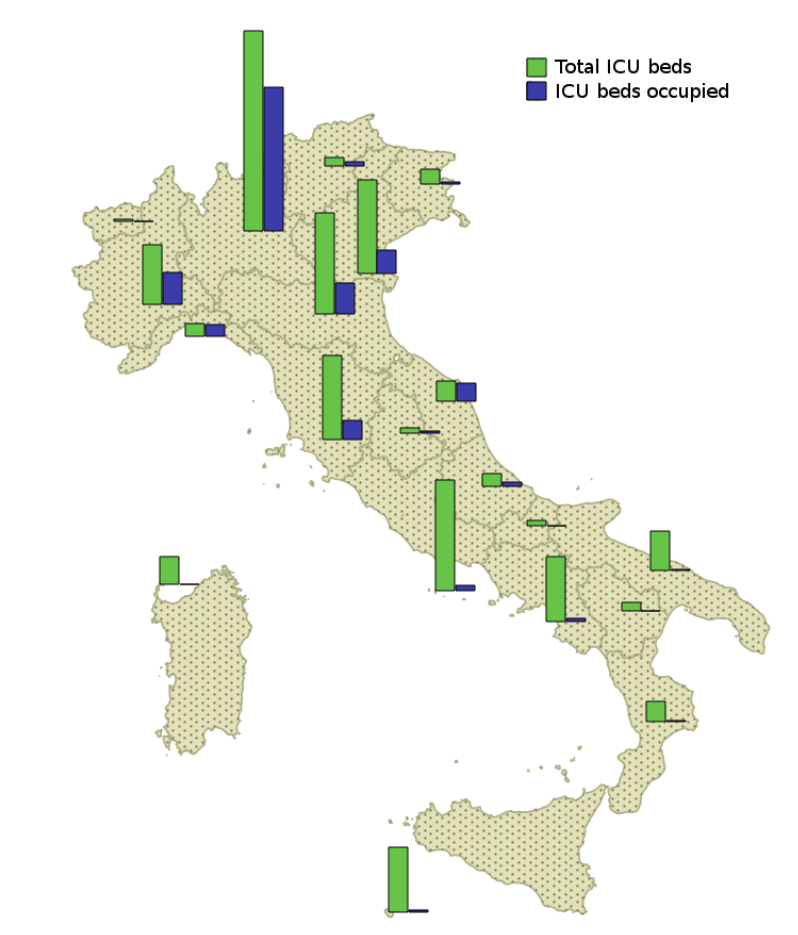
region. Data is available online on the Italian Civil Protection Department website at https://github. com/pcm-dpc/COVID-19/blob/master/dati-regioni/dpc-covid19-ita-regioni-20200315.csv with licence